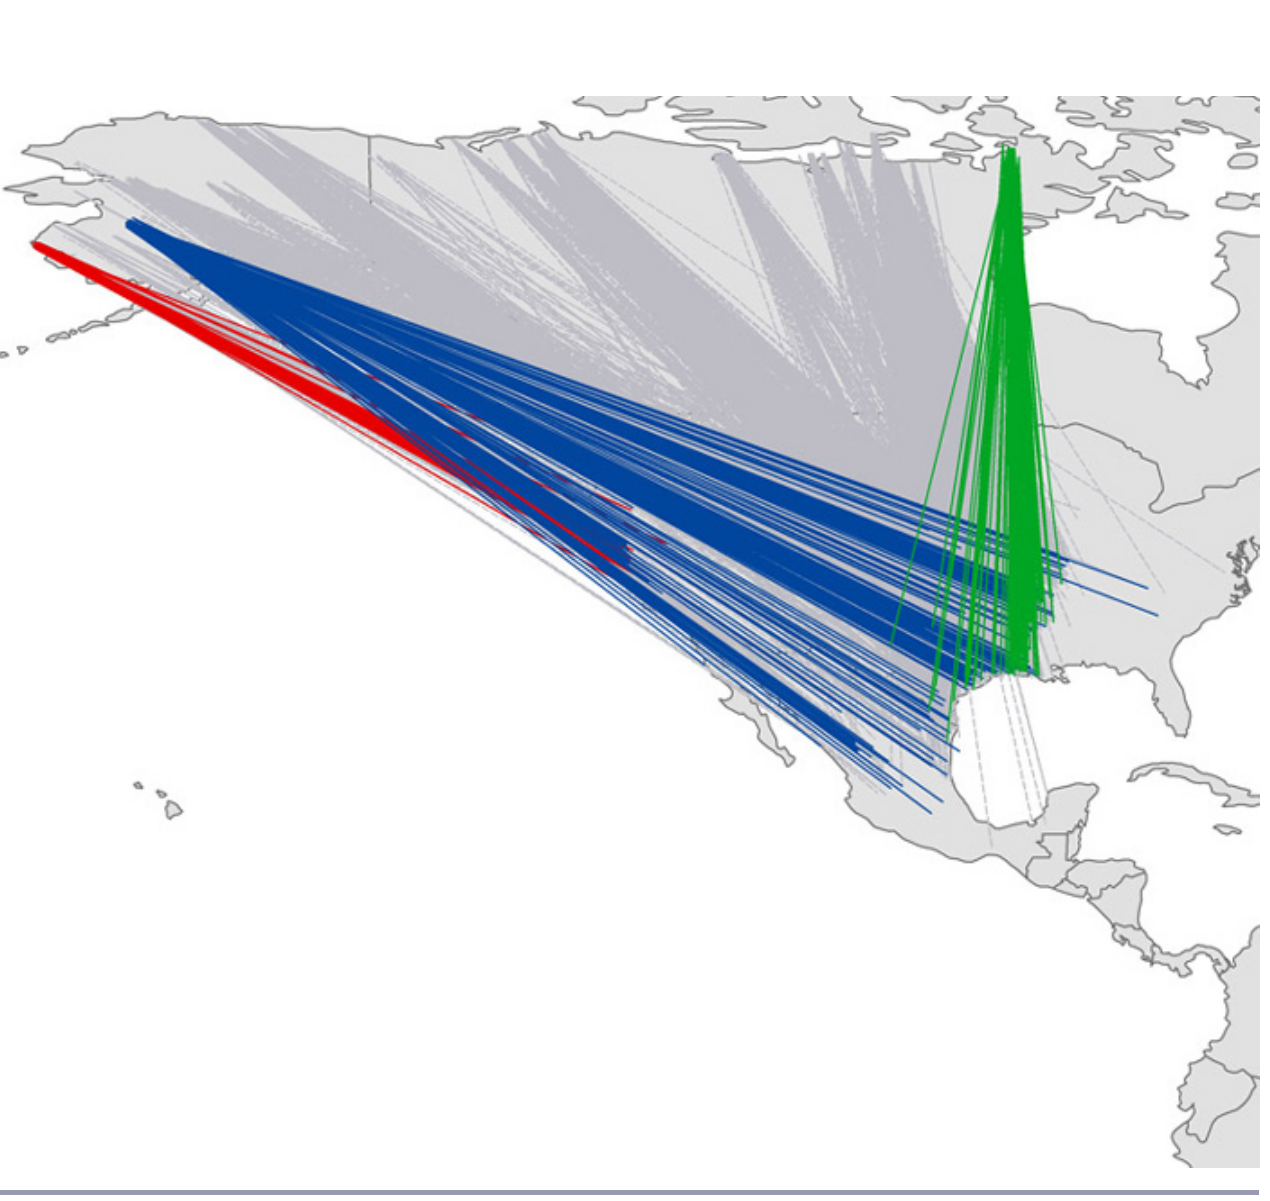
Fig. 5. Illustration of the complexities of bird migration, when information on connectivity of areas is considered, even within a single species. Here, U.S. Bird Banding Laboratory data on banding and recovery events in breeding and winter seasons of Greater White-fronted Geese ( Anser albifrons ) are plotted on a map of North America. Records, i.e., lines connecting breeding and wintering records corresponding to banding and recovery of a single individual, not intended to reflect migratory routes, from particular areas of the breeding range are highlighted in different colors. Note that a significant portion of the blue lines also stops along the Pacific coast of North America, coincident with the winter destination of the red lines, and that none of the red lines extends farther east than the west